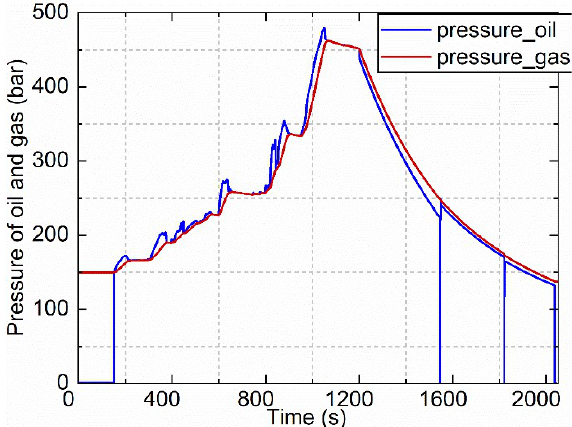
Figure 7. Pressure of hydraulic oil and